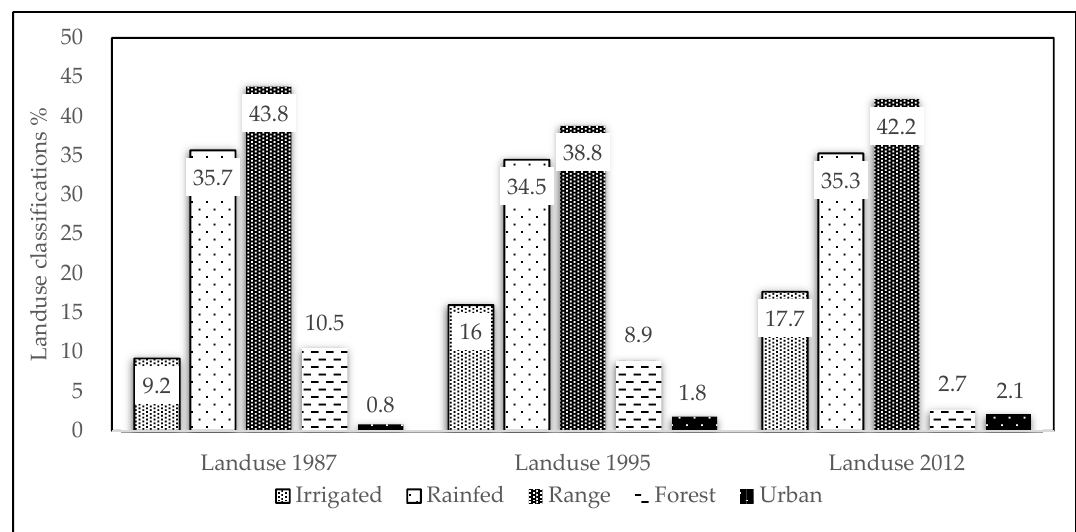
Figure 6. From left to right, KRB land use classifications before breakpoint (1987), during transition (1995), and after breakpoint (2012) periods.